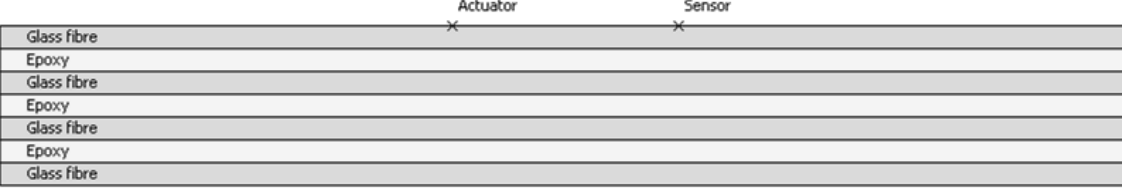
The 2D model of the plate was 7 mm overall thickness and 50 mm long. The simulation covered a period of 10 μs from the onset of the actuation signal. In reality, an experimental procedure would launch and receive the waves using actuators with physical properties of their own which should be modelled. To simplify matters here, point actuation and sensing at nodes of the model mesh are assumed. The 50 mm length was chosen to be sufficient to ensure that significant reflections from either end of the model did not reach the ‘sensor’ during the period of analysis, so that the simulation was equivalent to that for an infinite plate. The model was discretised into 0.25 mm square cells, giving a total of 5600 elements (28 by 200). LISA was used to simulate wave propagation between the actuator and sensor as shown in Fig. 7. The actuator and sensor were positioned 10 mm apart at the top of the plate. Five cycles of a sine wave with a Hanning window envelope were introduced into the plate as a time-varying